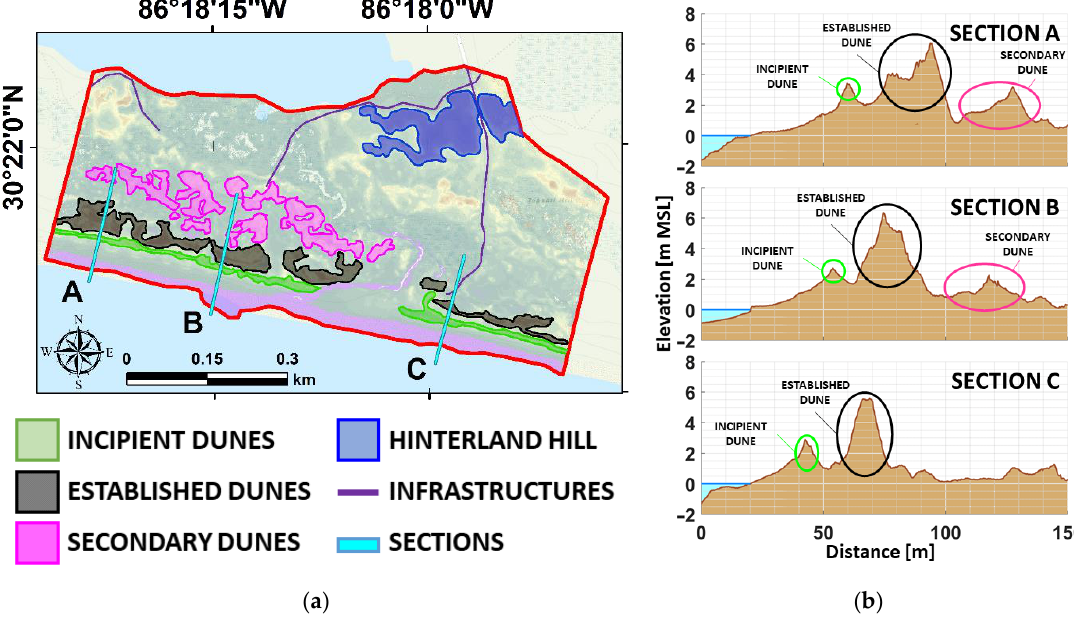
Figure 6. ( a ) Spatial distribution of the main features visible in the calculated ground elevation in our study domain. ( b ) Sections obtained from the calculated ground elevation calculated by apply- ing the genetic algorithm to the UAV – LIDAR point cloud. The circles describe the main features (i.e., dune type) visible in the sections. The background of the images in the first rows is the USGS national